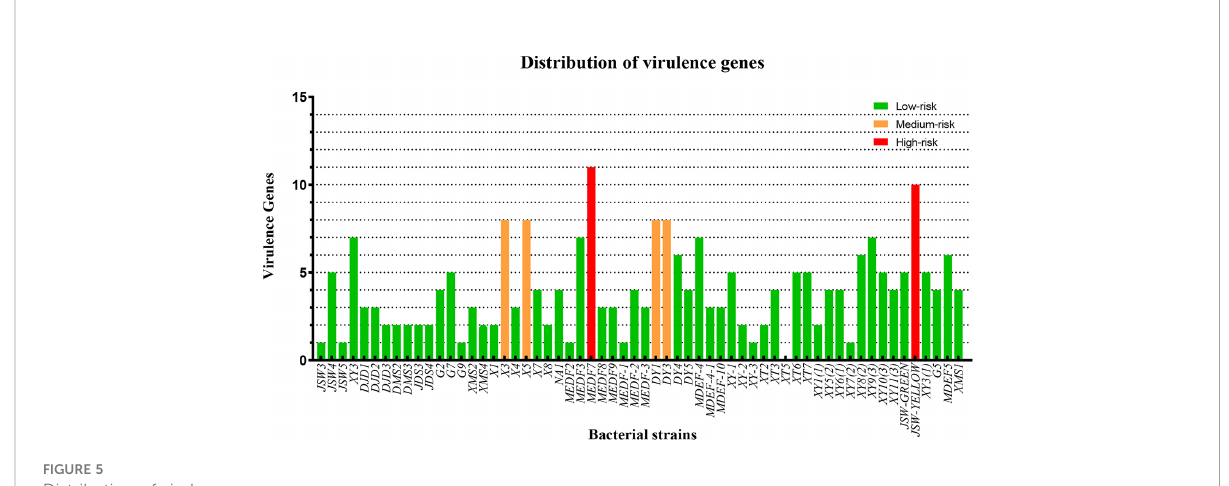
FIGURE 5 Distribution of virulence genes.